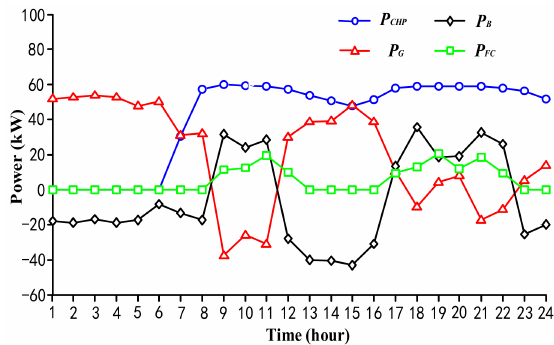
Figure 4. The optimal output power of different energy generators at β =